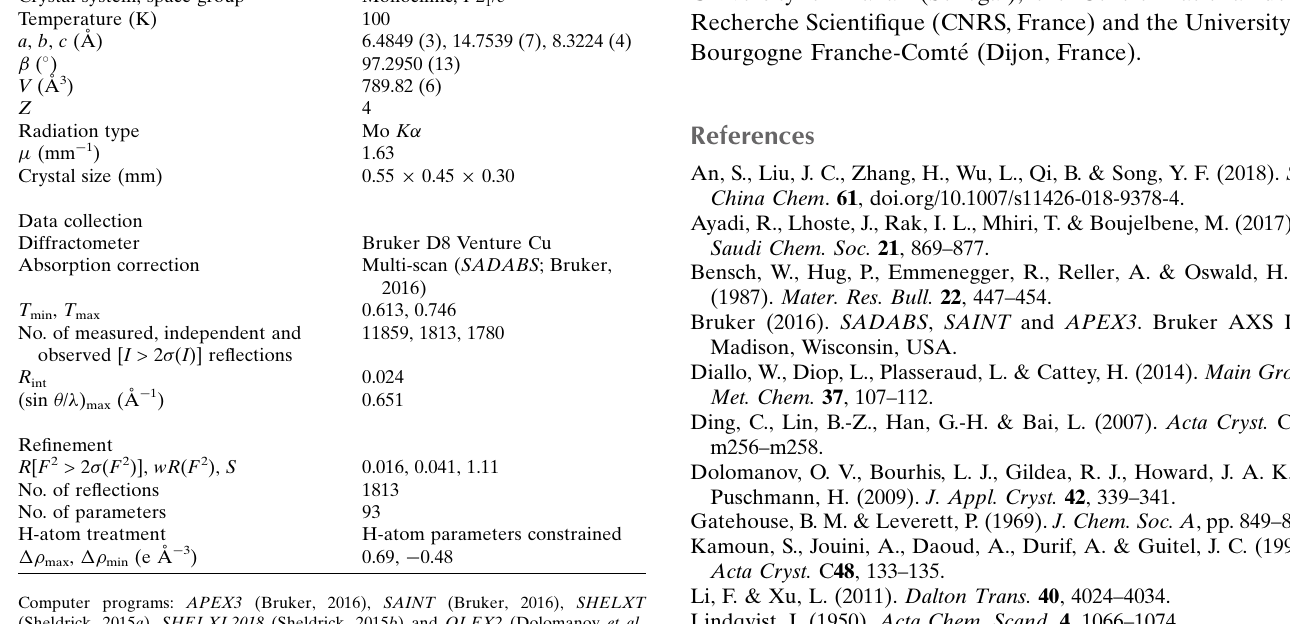
Table 3 Experimental details. Crystal data Chemical